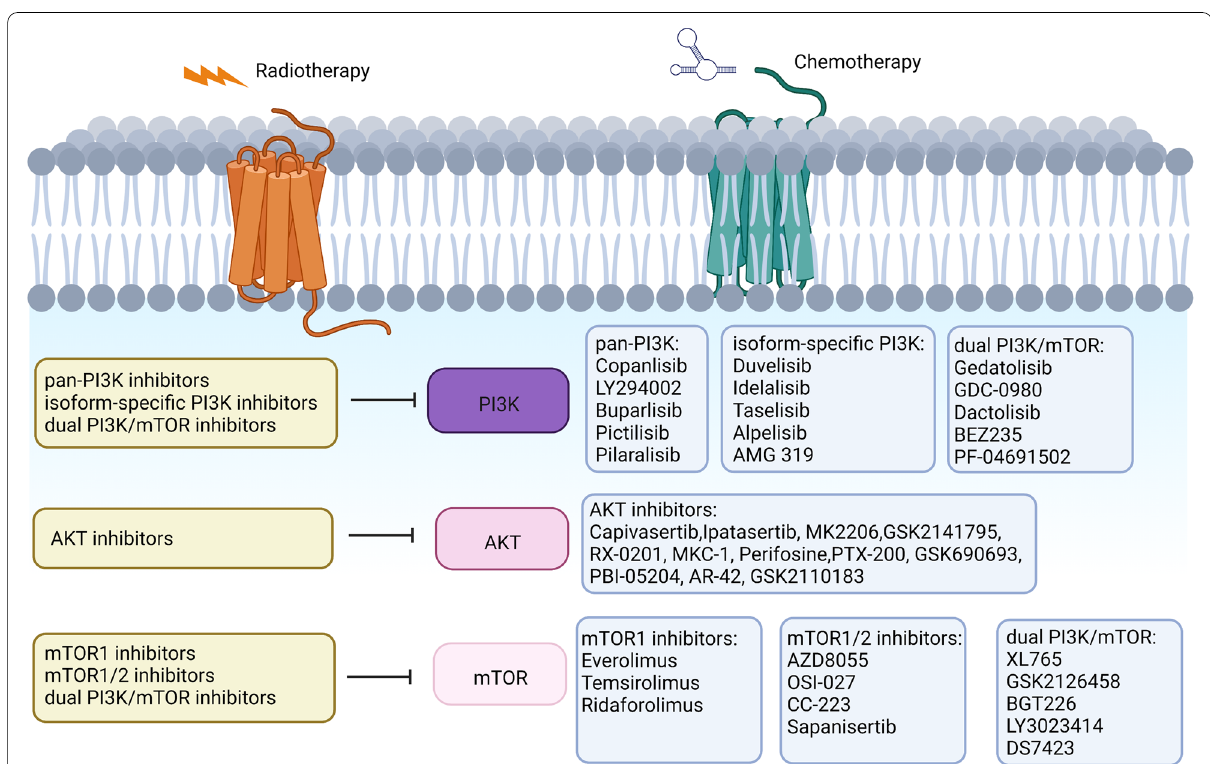
Fig. 2 Inhibitors of the PI3K/AKT/mTOR pathway. Various classes of agents target different effectors of the PI3K/AKT/mTOR